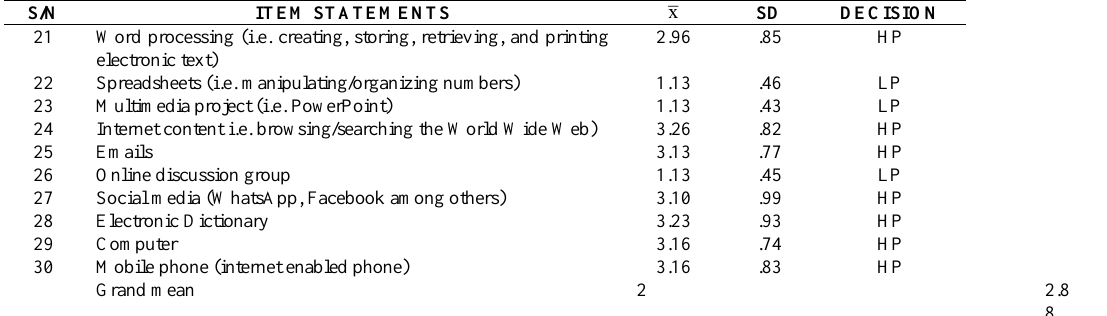
Table 3: Mean and standard deviation of the extent of proficiency in utilising technology (ICT) in teaching of English language in Nsukka